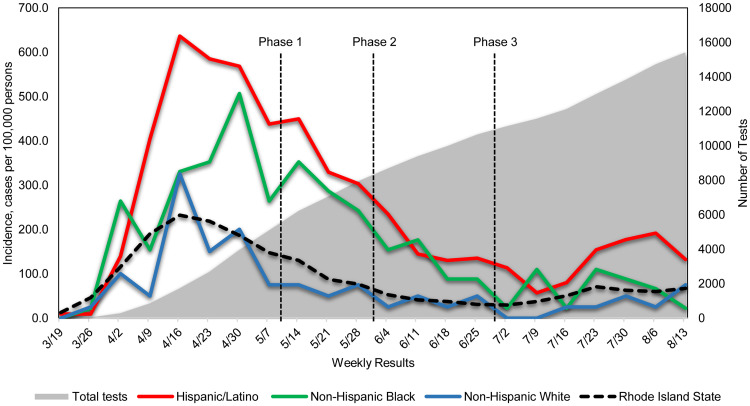
New positive COVID-19 cases and estimated incidence by race/ethnicity group and week. The red line represents the weekly COVID-19 incidence of the Hispanic/Latino population over reopening phases 1−3 compared to other populations. The weekly incidence rates among the Hispanic/Latino population have been significantly higher than the statewide weekly incidence rates since the pandemic throughout the reopening phases. The shaded grey area represents the total number of cumulative tests over time.